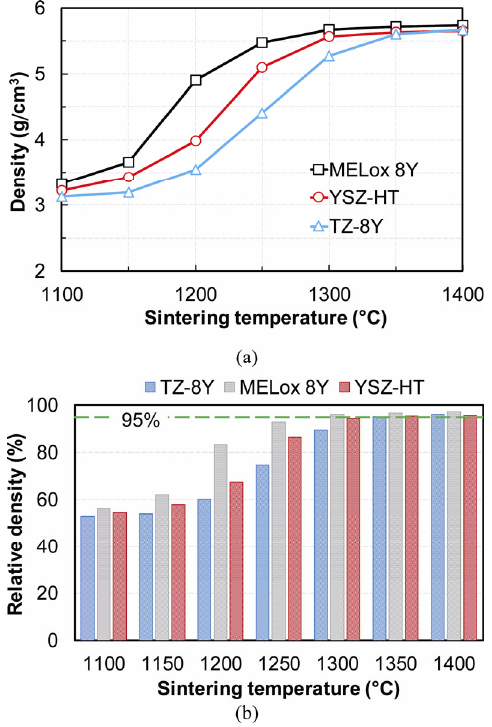
Fig. 5 (a) Density and (b) relative density of the YSZ pellets at different sintering